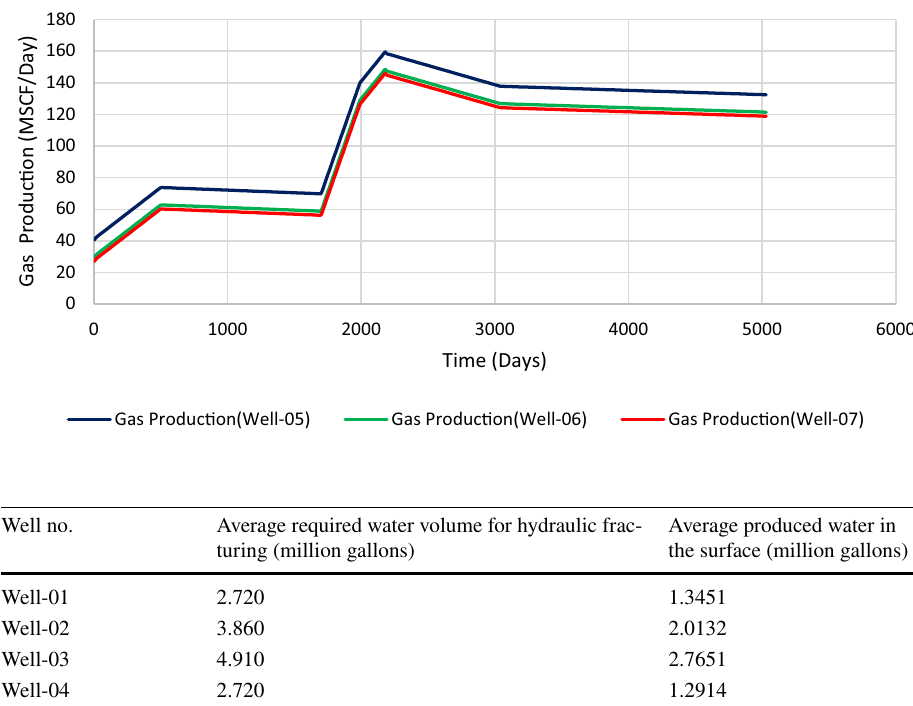
Fig. 11 Gas production after hydraulic fracturing